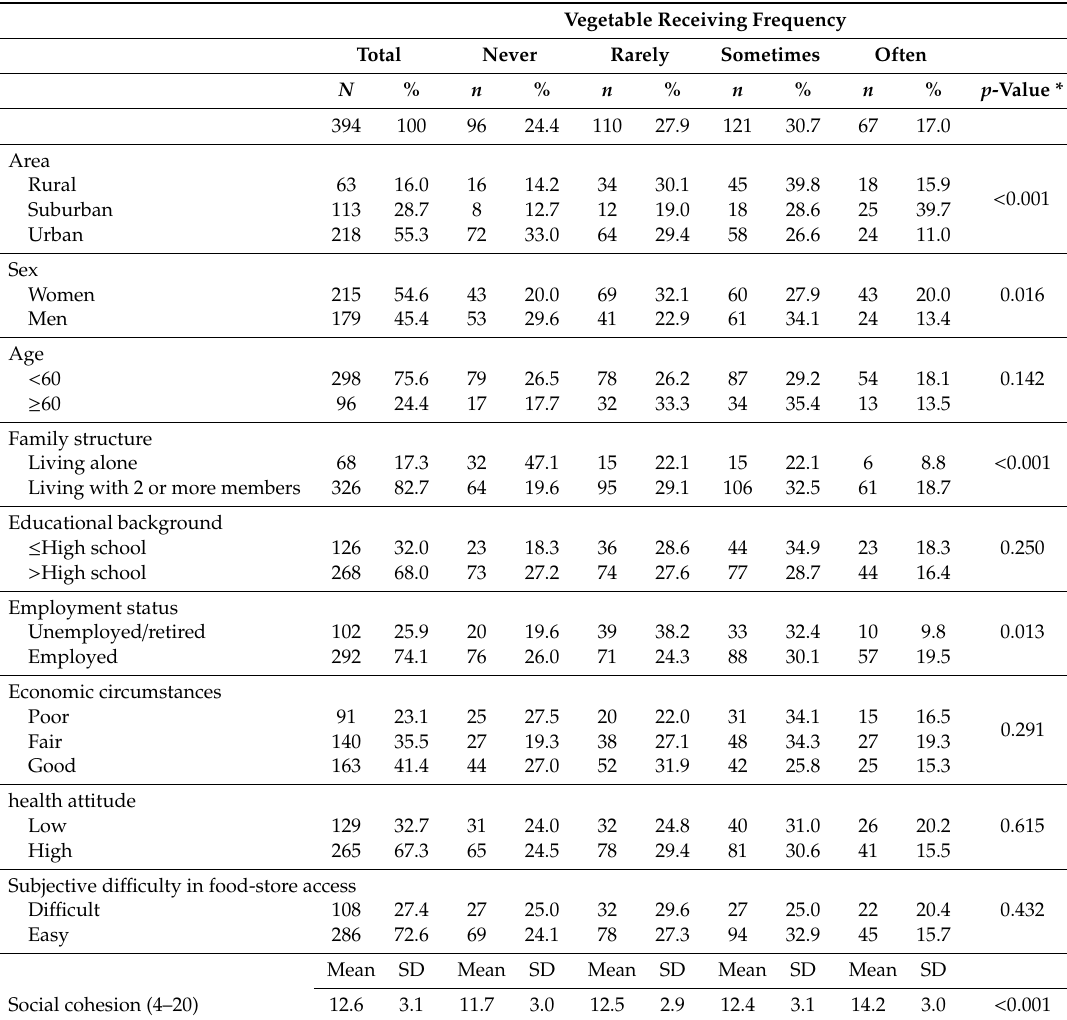
Table A3. Participants’ characteristics according to vegetable receiving frequency among non-gardeners (Survey